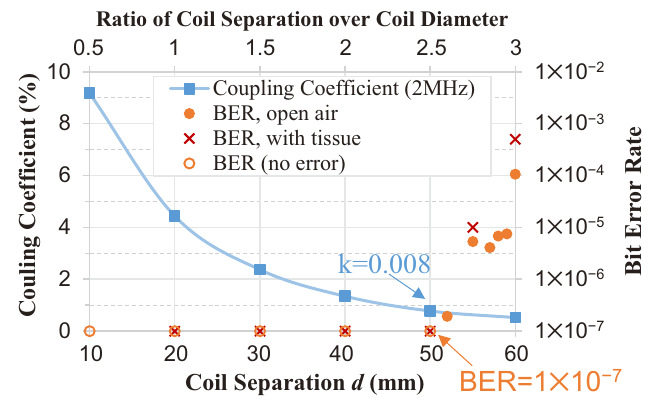
Figure 16. The measured uplink BER and the coupling coefficient versus the coil separation, when the PDL is kept constant at 5 mW.